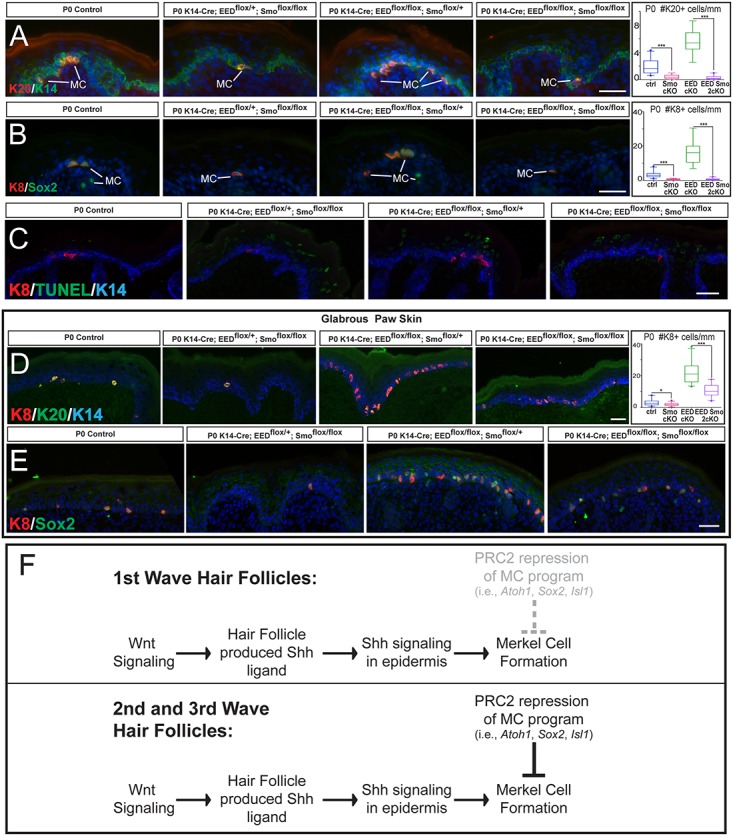
Concurrent loss of PRC2 and Shh signaling in the epidermis results in dramatically reduced numbers of Merkel Cells.(A-B) IF stainings for Merkel cell (MC) markers Krt20 (K20) (A), Krt8 (K8) (B), and Sox2 (B) show a dramatic reduction in the number of Merkel cells in P0 EED Smo epidermis-conditional double knockout (EED Smo 2cKO) (K14-Cre; EEDflox/flox;Smoflox/flox) mice compared to control (ctrl) and EED cKO (K14-Cre; EEDflox/flox; Smoflox/+) mice. Quantification of the number of Krt20(+) quantified to the right of A (ctrl vs. Smo cKO, p<0.0001; EED cKO vs. EED Smo 2cKO, p<0.0001). Quantification of number of Krt8(+) quantified to the right of B (ctrl vs. Smo cKO, p<0.0001; EED cKO vs. EED Smo 2cKO, p<0.0001). (C) TUNEL staining shows no increase in apoptosis in the Krt14(+) basal layer of P0 EED Smo 2cKO. Note that cells undergoing cornification in the suprabasal layers stain positive for TUNEL, as previously reported [33]. (D,E) IF stainings for Merkel cell markers Krt8 (D, E), Krt20 (D), and Sox2 (E) show that significantly fewer Merkel cells are present in the glabrous paw skin of P0 EED Smo 2cKO mice compared to EED cKO paws. Quantification of Krt8(+) cells (right panel of D) (ctrl vs. Smo cKO, p = 0.0317; EED cKO vs. EED Smo 2cKO, p<0.0001). (F) Schematic diagram of the signaling events regulating Merkel cell specification in first wave of hair follicle development. Hair follicle dependent intraepidermal signaling promotes Merkel cell specification. These signaling events also occur during second and third wave of hair follicle morphogenesis but these hair follicles do not harbor Merkel cells due to PRC2-mediated repression of Merkel genes. Scale bars: (A-E): 25 μm.